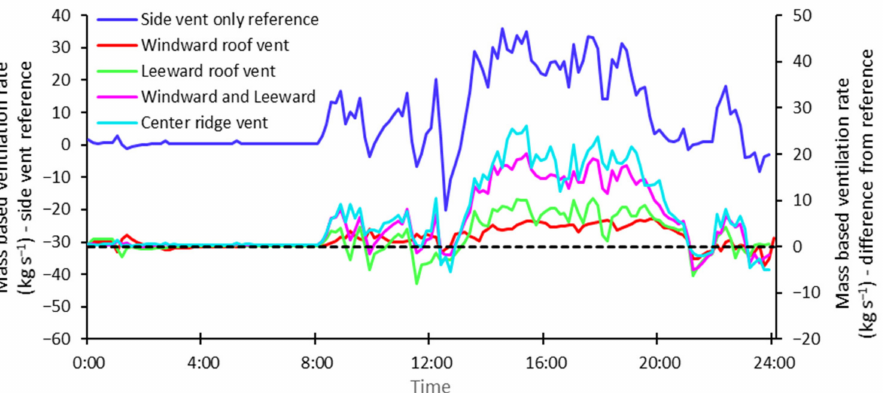
Figure 7. Mass-based ventilation rate at the leeward vent/vents for the different roof vent designs evaluated. The primary y-axis represents the actual air flow rates for the side vent only design as a reference. The right axis represents the air flow rates at the leeward vent/vents of the other designs subtracted by the side vent only reference (positive values mean higher air flow rates relative to the reference case). Table 4. Simulated average mass-based ventilation rates through the leeward vent(s) depending on the configuration of the roof vent(s). Average outside wind speed at 2.5 m: 1.5 m s − 1 . Wind